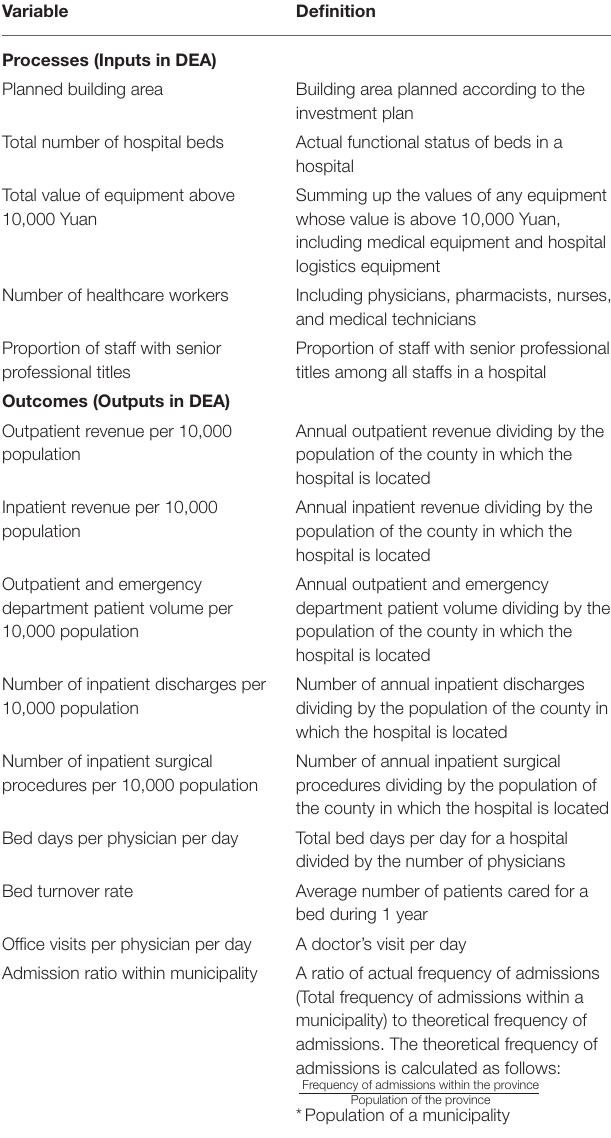
TABLE 1 | Definition of input and output